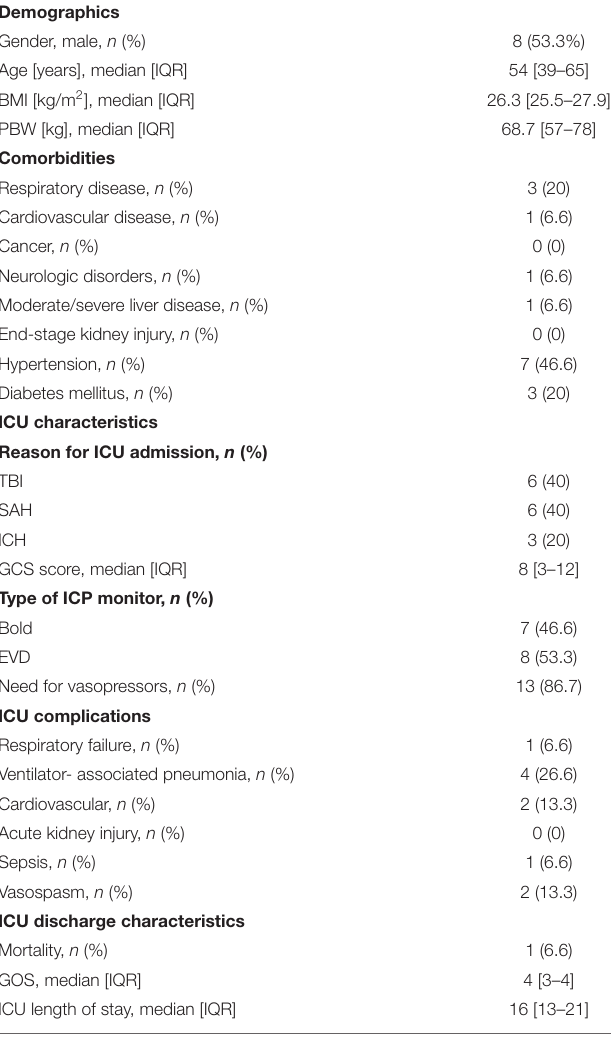
TABLE 1 | Characteristics of the patients at ICU admission.